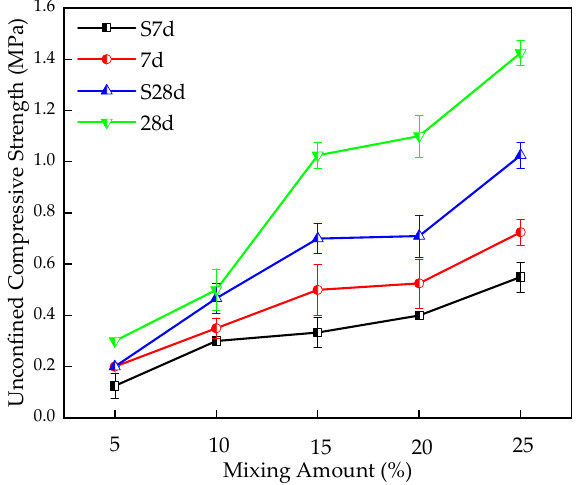
Figure 7. Effect of TG on UCS of stabilized silt.